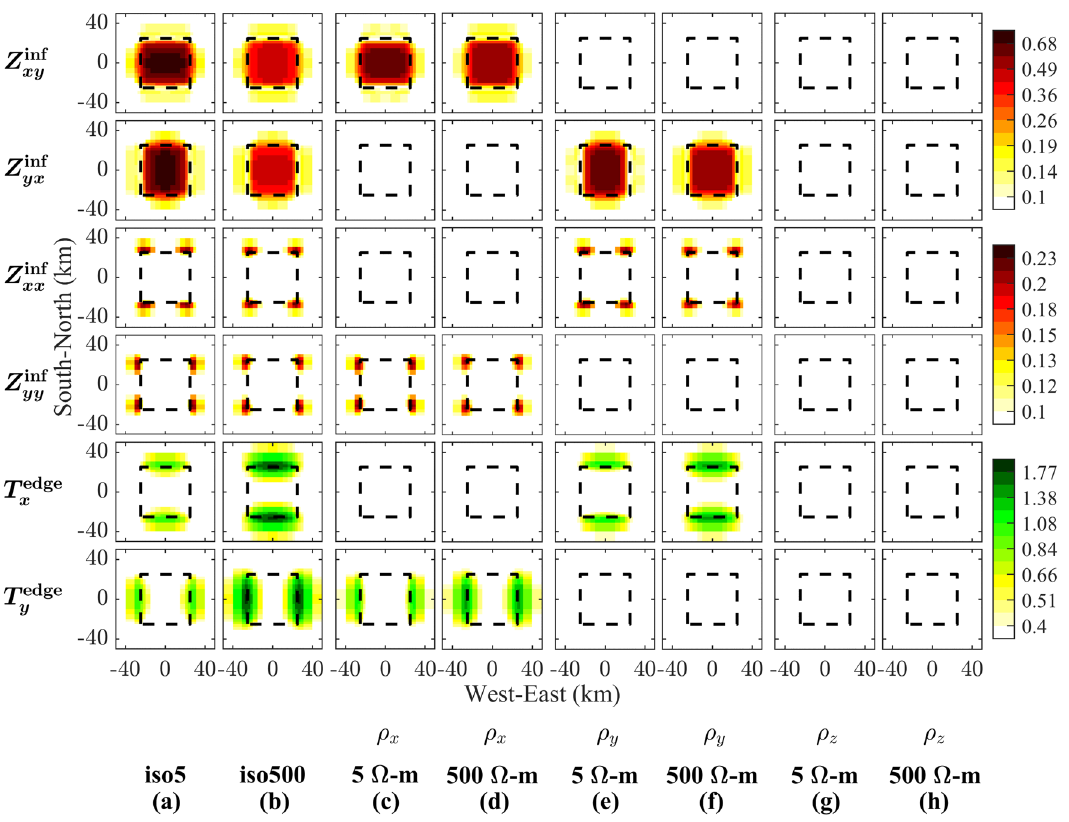
Fig. 3 The surface logarithmic plot of the impedance tensor influence indices Z inf xy ( s ) , Z inf yx ( s ) , Z inf xx ( s ) , and Z inf yy ( s ) and the tipper edge effect indices T edge x ( s ) , and T edge y ( s ) at all 484 stations from top to bottom rows, respectively, obtained from (a) the iso5 model, (b) the iso500 model (c) ρ x Ω‑m, (d)